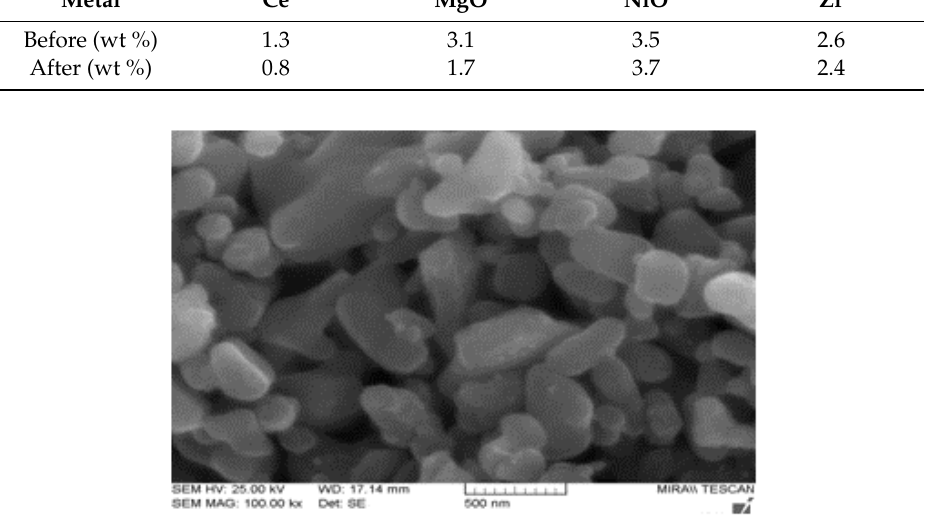
Figure 7. SEM image of the 3 wt% Ni/Ce-ZrO 2 /Al 2 O 3 catalyst.